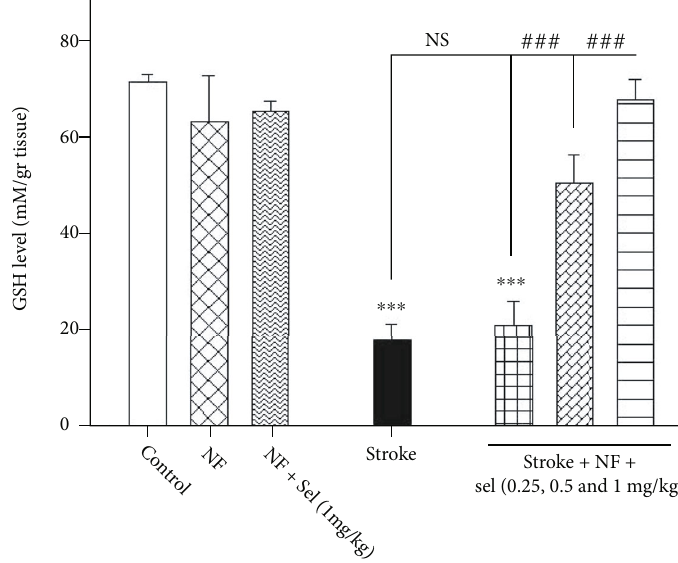
Figure 8: E ff ects of selegiline on glutathione level in the brain. Values are expressed as the mean ± SD and were analyzed using one-way ANOVA followed by Tukey ’ s post hoc test ( n = 3 ). ∗ P < 0 : 05 , ∗∗ P < 0 : 01 , and ∗∗∗ P < 0 : 001 compared with control group. # P < 0 : 05 and ## P < 0 : 01 and ### P < 0 : 001 compared with transient global ischemia rats. “ NF = nanoformulated containing NBP; NF+sel = nanoformulated containing NBP+selegiline.